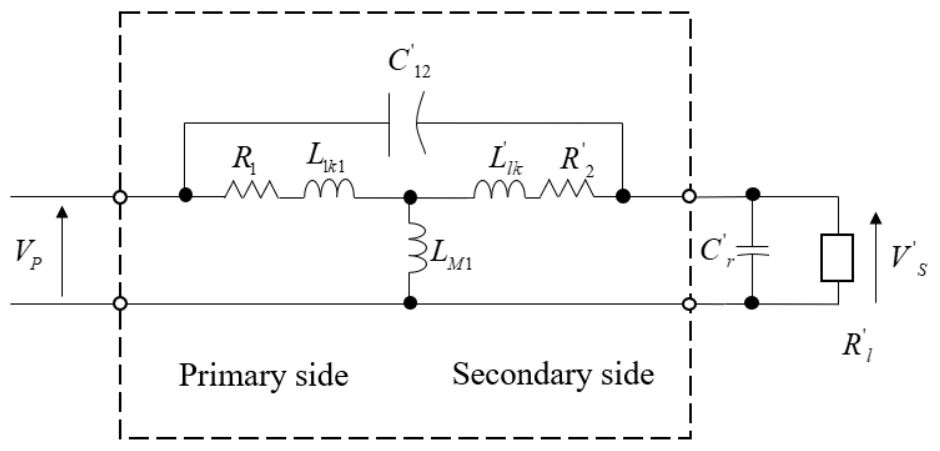
Figure 1. Circuit model of